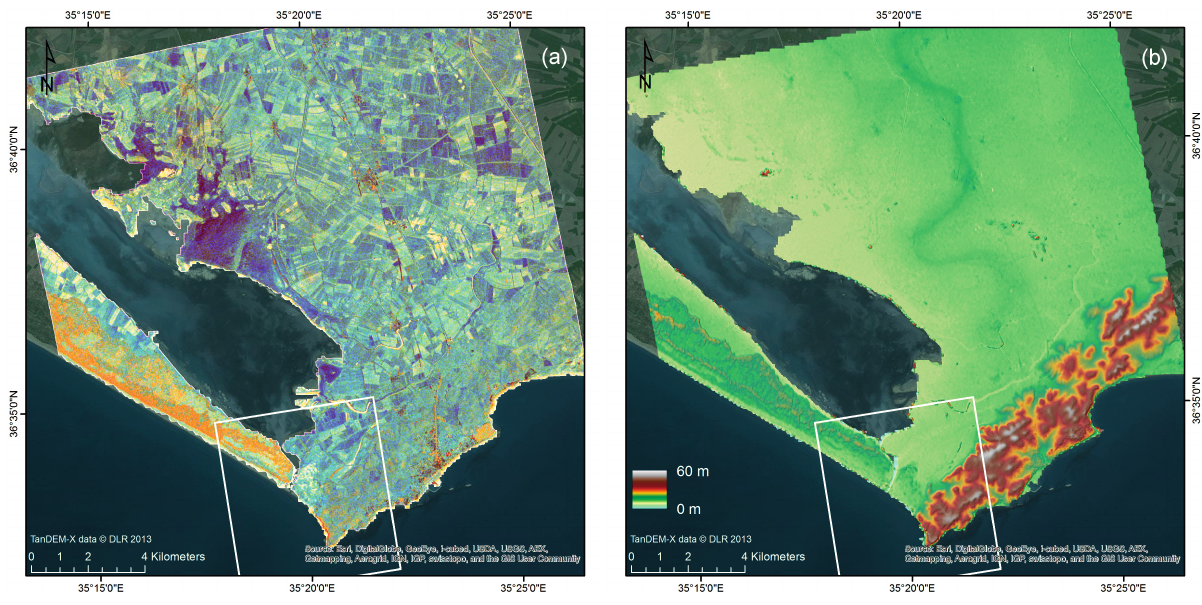
Figure 3. Overview of the wider study area in the Cilician Plain, Turkey, using TanDEM-X Stripmap products. ( a ) RGB color composite (Red = coherence; Green = mean Intensity; Blue = intensity difference between the monostatic and the bistatic radar backscatter; inverted color ramps, see explanation in text). ( b ) TanDEM-X Stripmap DEM (bistatic 2) resampled to 7 m resolution. The white frame indicates the extent of the TanDEM-X HS products.